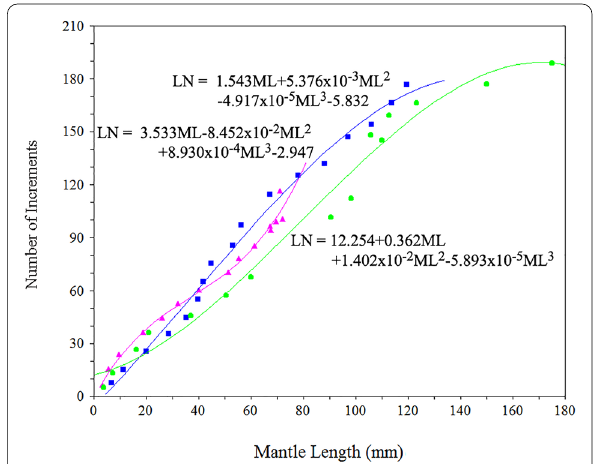
Fig. 1 Relationships between mantle length (mm) and